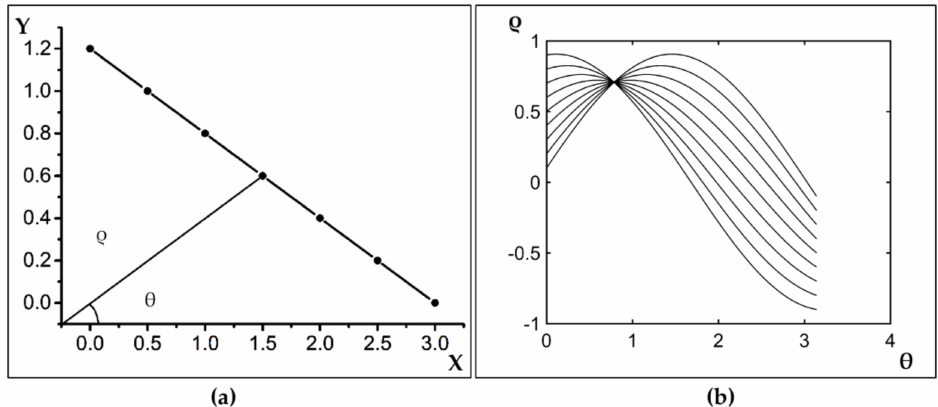
Figure 3. A schematic diagram of the Hough transform, where ( a ) shows a schematic diagram of the Cartesian coordinates, and ( b ) shows the parametric space curve